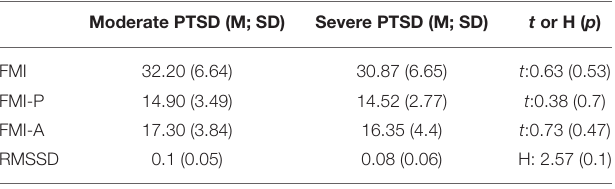
TABLE 1 | Psychophysiological characteristics of moderate and severe PTSD groups. Moderate PTSD (M; SD)